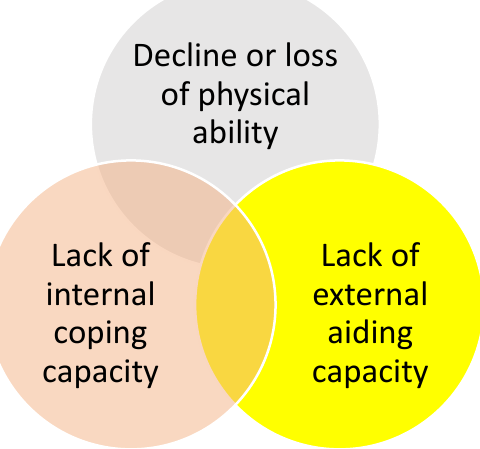
Figure 10. Framework for assessing flood vulnerability in an aging society.